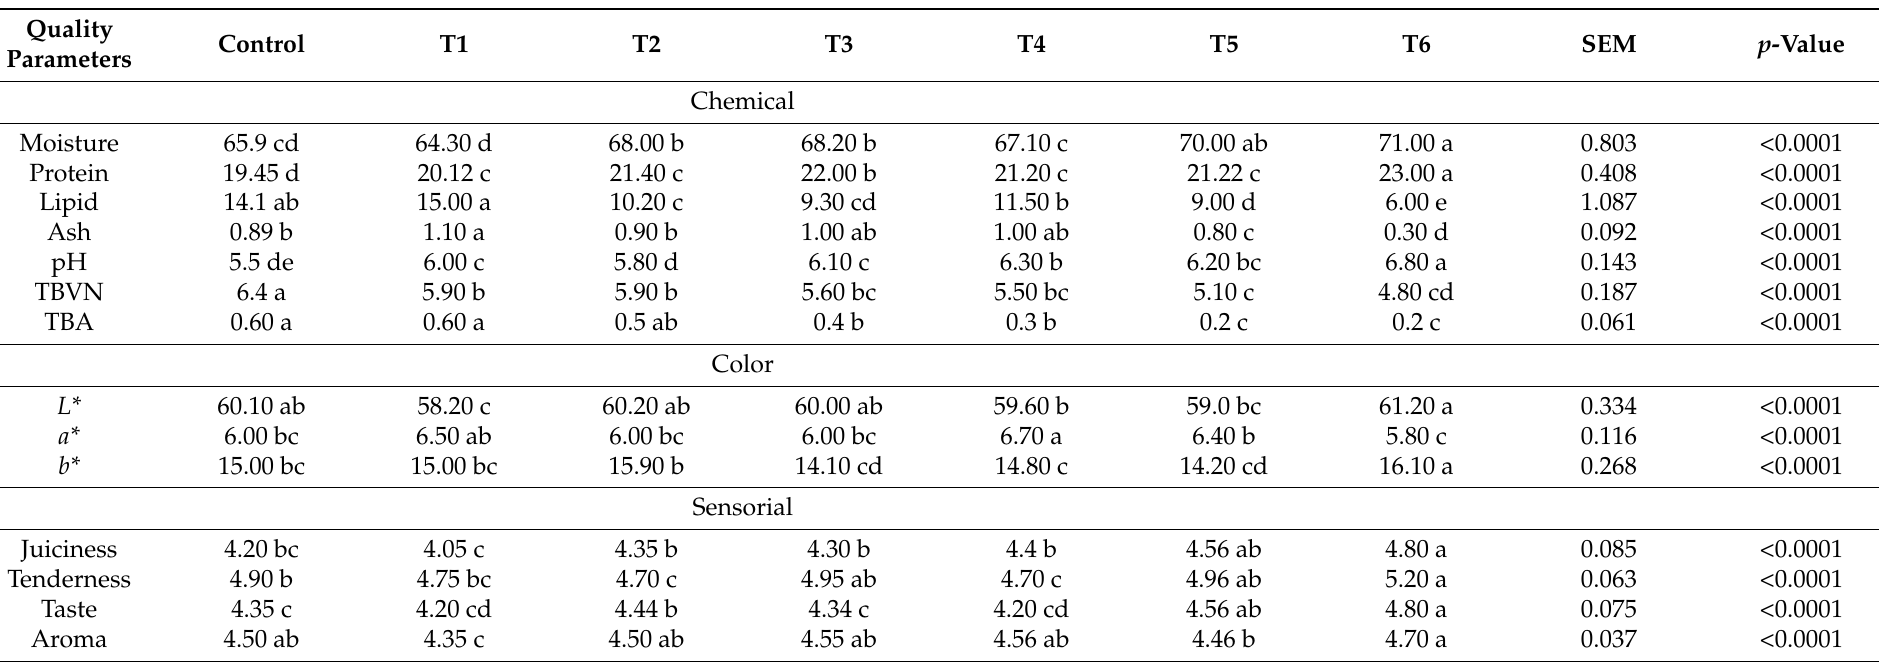
Table 6. Chemical, color parameters, and raw and cooked (sensorial) meat quality of broiler affected by dietary supplementation of ZnNPs, CurNPs, and Bacillus licheniformis . ( n = 6). Quality Parameters